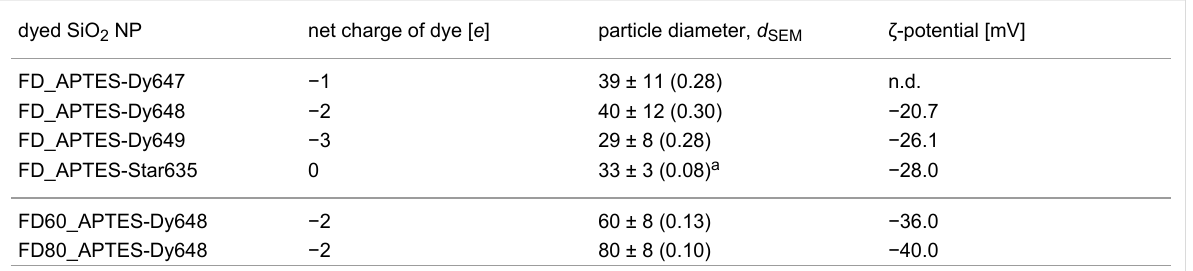
Table 3: Overview of the physical particle attributes of dye–APTES-modified silica nanoparticles. Particle diameter and size distribution of the sam- ples were characterised by SEM image analysis and the particle charge was determined by ζ -potential measurements. Numbers in brackets indicate the size dispersity p . n.d. = not determined.